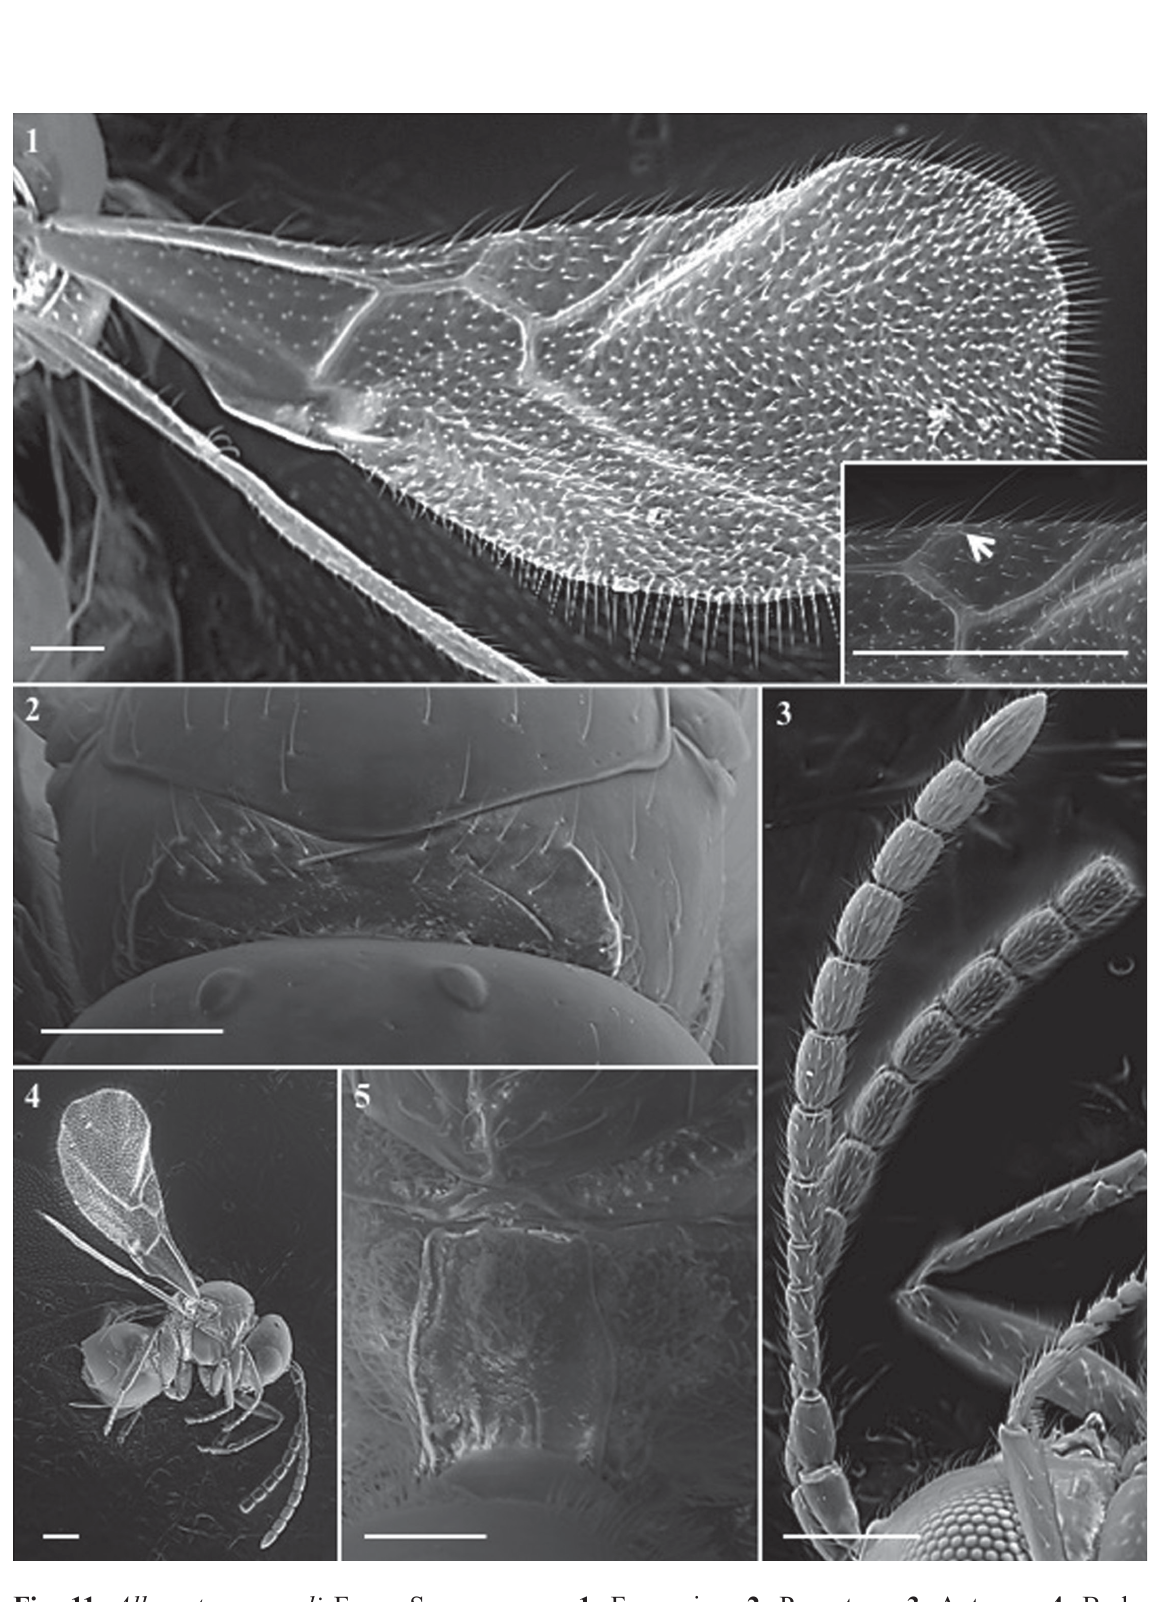
Fig. 11. Alloxysta pascuali Ferrer-Suay sp. nov. 1 . Fore wing. 2 . Pronotum. 3 . Antenna. 4 . Body. 5 . Propodeum. Scale bars: 50